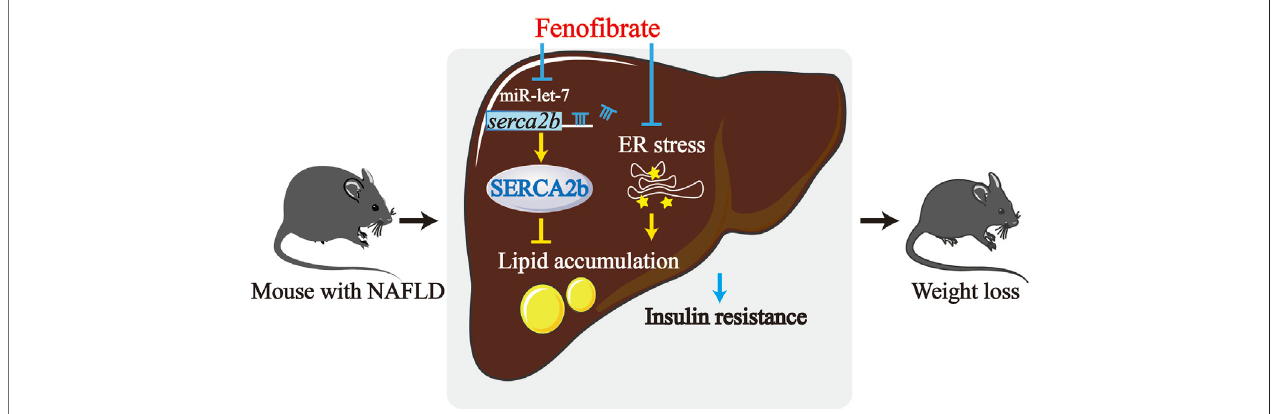
FIGURE 6 | The mechanism of feno fi brate that leads to improved hepatic lipid accumulation and insulin resistance. The levels of let-7 are upregulated in HFD- induced obese (DIO) mice. Feno fi brate reduced the levels of the let-7 family members and upregulated the levels of SERCA2b, which is a target of let-7. Feno fi brate treatmentalsoattenuatedinsulinresistanceandsuppressedexcessivelipidaccumulationinHFD-fedmice.Thus,theprotectiveeffectoffeno fi bratecouldbereasonably related to alteration of the let-7/SERCA2b axis and alleviation of ER